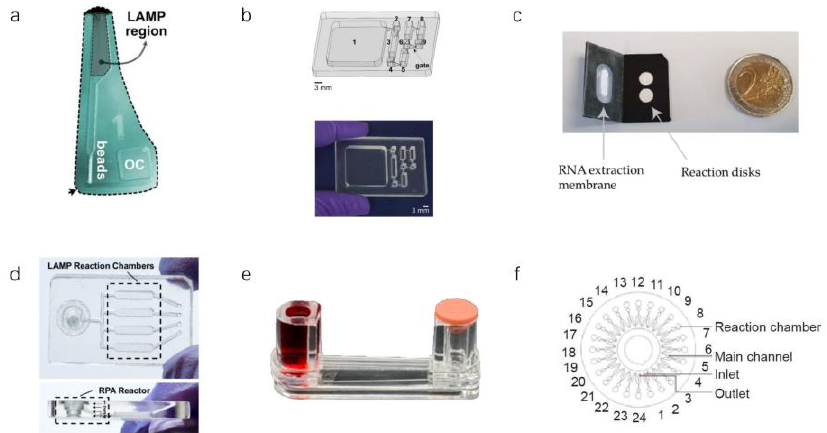
Figure 7. Several essential microfluidic chips for detecting SARS-CoV-2 using isothermal amplification. ( a ) PMMA microfluidic chip based on accurate LAMP detection [68]. ( b ) Microfluidic chip and liquid flow diagram of IFAST RT-LAMP [69]. ( c ) Paper-based microfluidic chip composed of polypropylene (black) and glass fiber (in white) [70]. ( d ) LAMP reaction region and RPA reaction region in microfluidic chip [18]. ( e ) Microfluidic detection device based on DNA gel [72]. ( f ) Schematic diagram of microfluidic chip [14]. (Copyright © The Royal Society of Chemistry 2021) (Copyright © 2021 Elsevier B.V. All rights reserved.) (Copyright © 2021 Garneret et al.) (Copyright © 2021 Elsevier